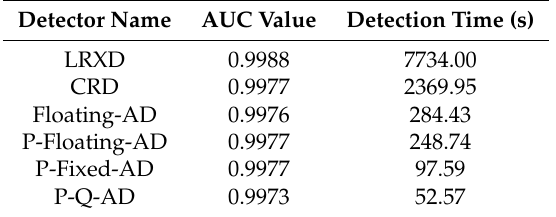
Figure 18. The receiver operating characteristic (ROC) curve for Louisiana dataset. Table 5. The area under the curve (AUC) value and the detection time consumption of Louisiana data